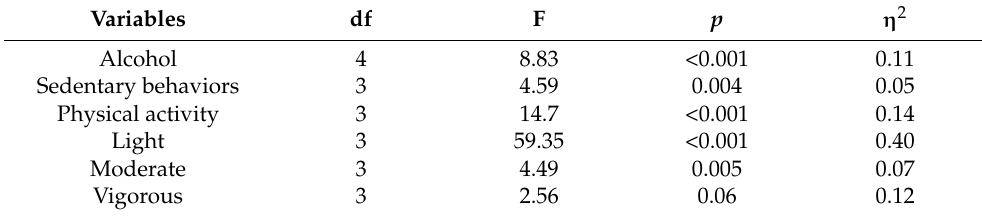
Table 2. Repeated measures ANOVA